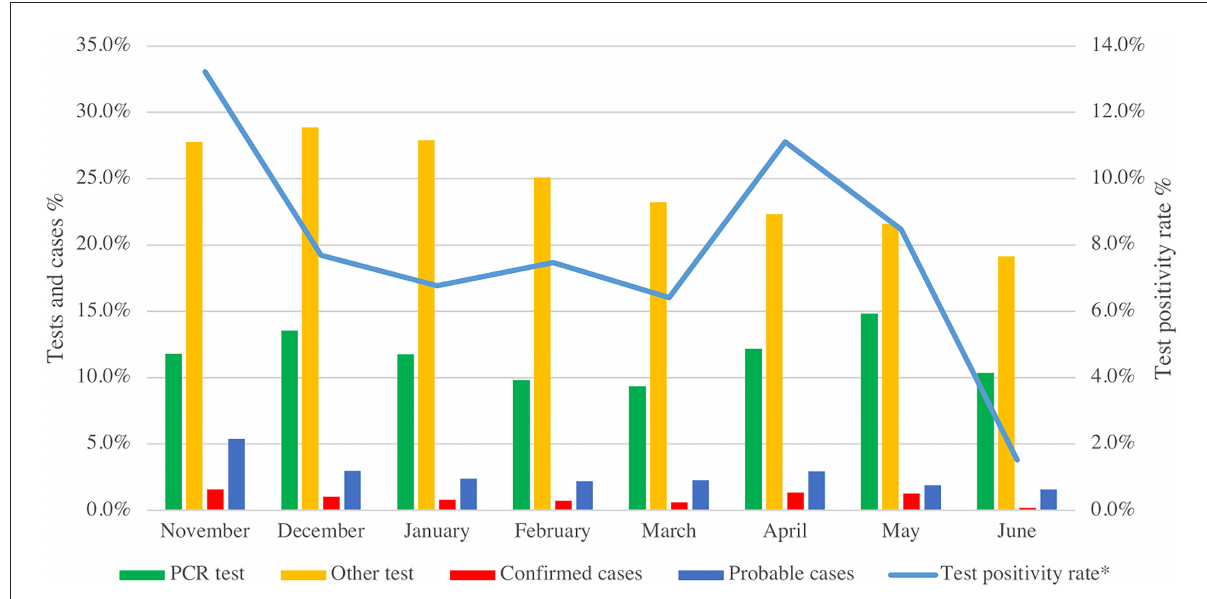
FIGURE3 PREPCOVI testing and COVID-19 cases (confirmed and probable) distribution from November 2020 to June 2021. * Positivity rate is based on confirmed cases detected by PCR tests for SARS-CoV-2.